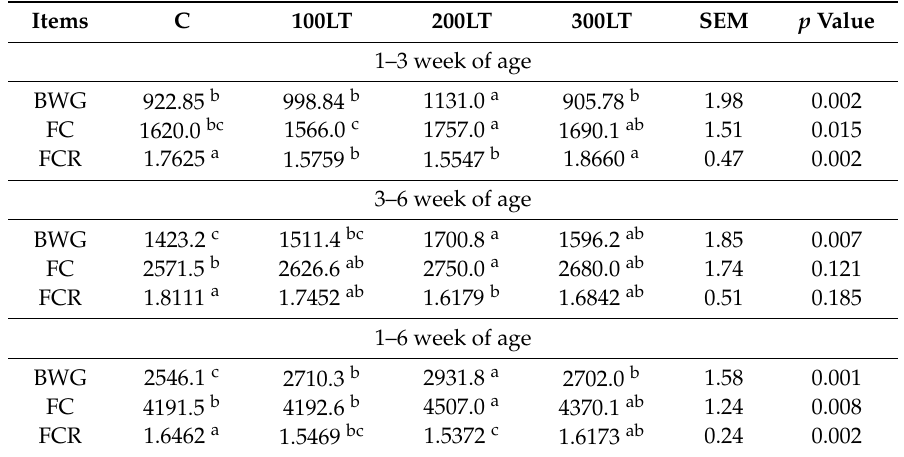
Table 1. Growth performance traits of broilers as affected by dietary L -theanine supplementation within the whole experimental period and the